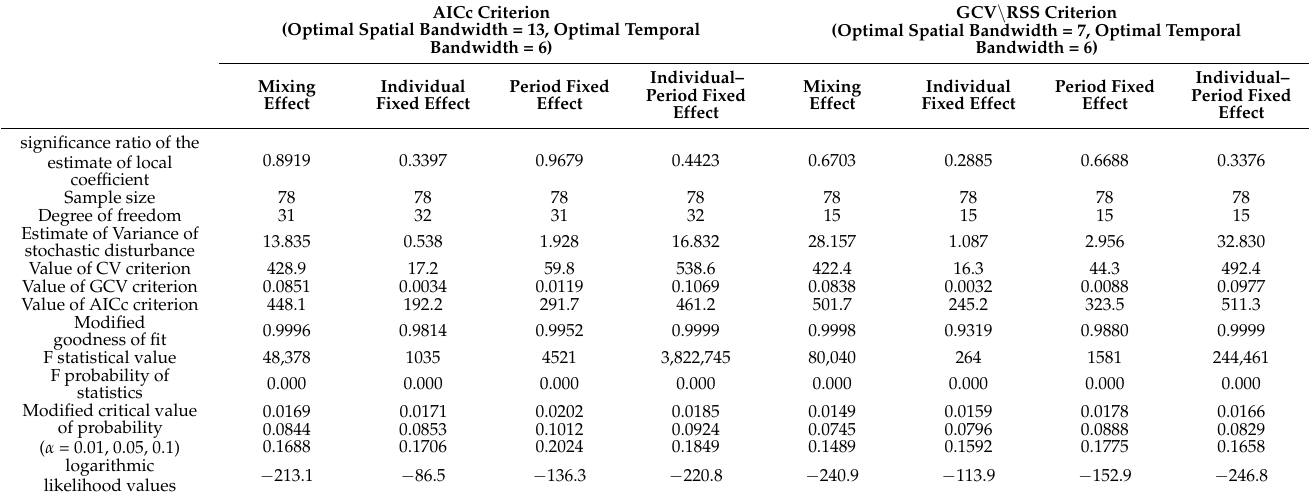
Table 3. Overall statistical properties of the example model under the two bandwidth dimensions and four kinds of